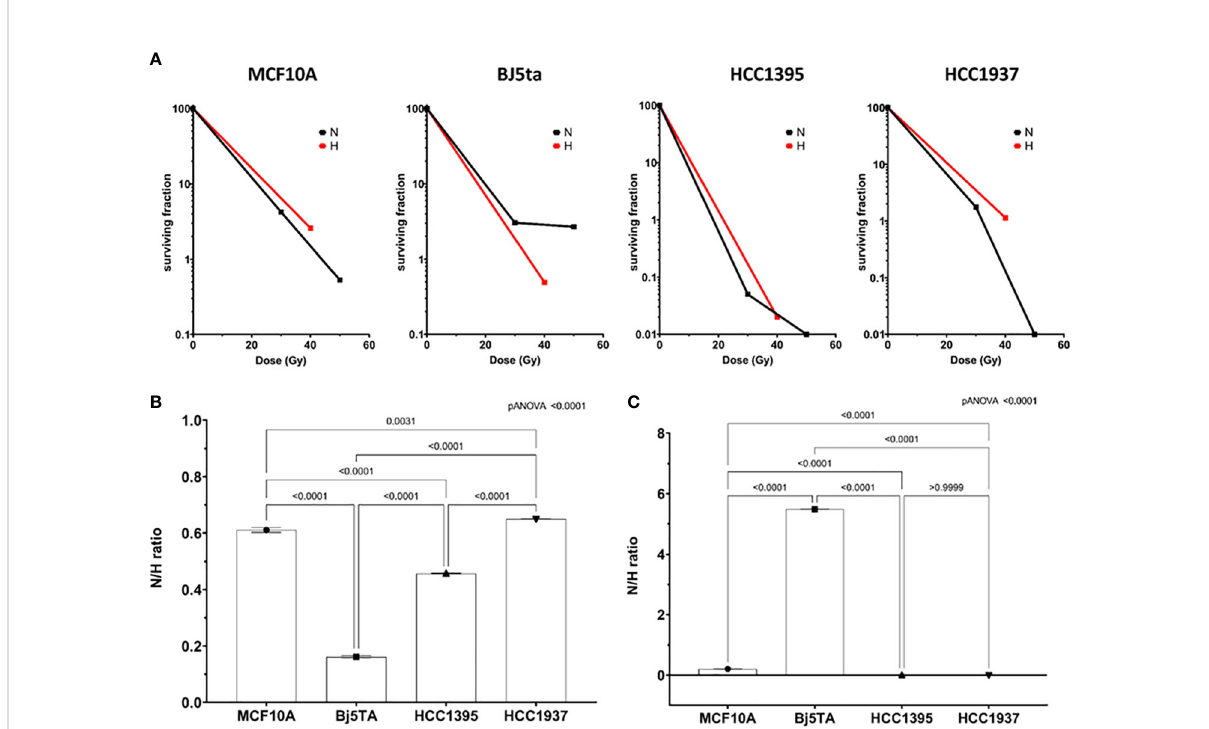
FIGURE 6 Survival after hypofractionated and conventional multifractionated radiotherapy. Clonogenic survival of the employed cell lines after irradiation with the corresponding multifractionated protocol (A) . The red line and H represent HypoRT, the black line and N represent NormRT. Non-irradiated cells were used as control for performing modi fi ed CFA. Ef fi cacy of HypoRT versus NormRT radiotherapy at irradiation day 15 after a cumulative dose of 40.05 Gy (HypoRT) or 30 Gy (NormRT) (B) . The ratio of HypoRT to NormRT survival was calculated as follows: surviving fraction after 40.05 Gy/ surviving fraction after 30 Gy. Ef fi cacy of HypoRT versus NormRT radiotherapy by the end of both irradiation protocols. (C) . The ratio of HypoRT to NormRT survival was calculated as follows: surviving fraction after a cumulative dose of 40.05 Gy/surviving fraction after a cumulative dose of 50